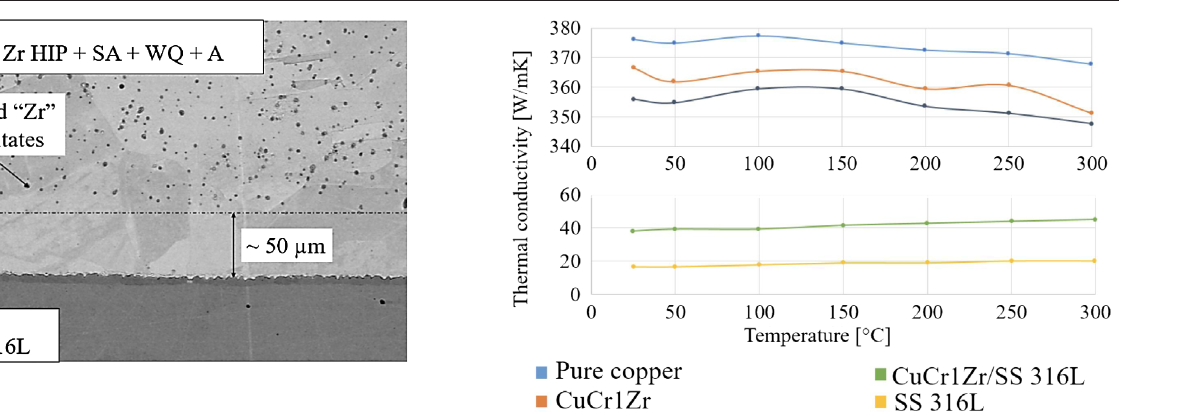
FIG. 9. SEM image 500 × of the CuCr1Zr-SS 316L interface. Dark Cr and Zr precipitates consolidated during aging are visible on the CuCr1Zr side.